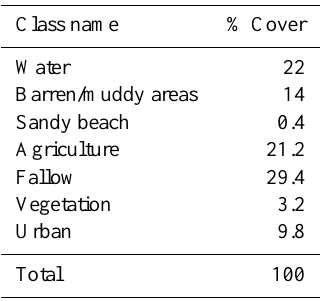
Fig. 8. Vulnerability ranking map of land use/land cover. Table 3. Areal distribution of LU/LC classes as percentage cover.